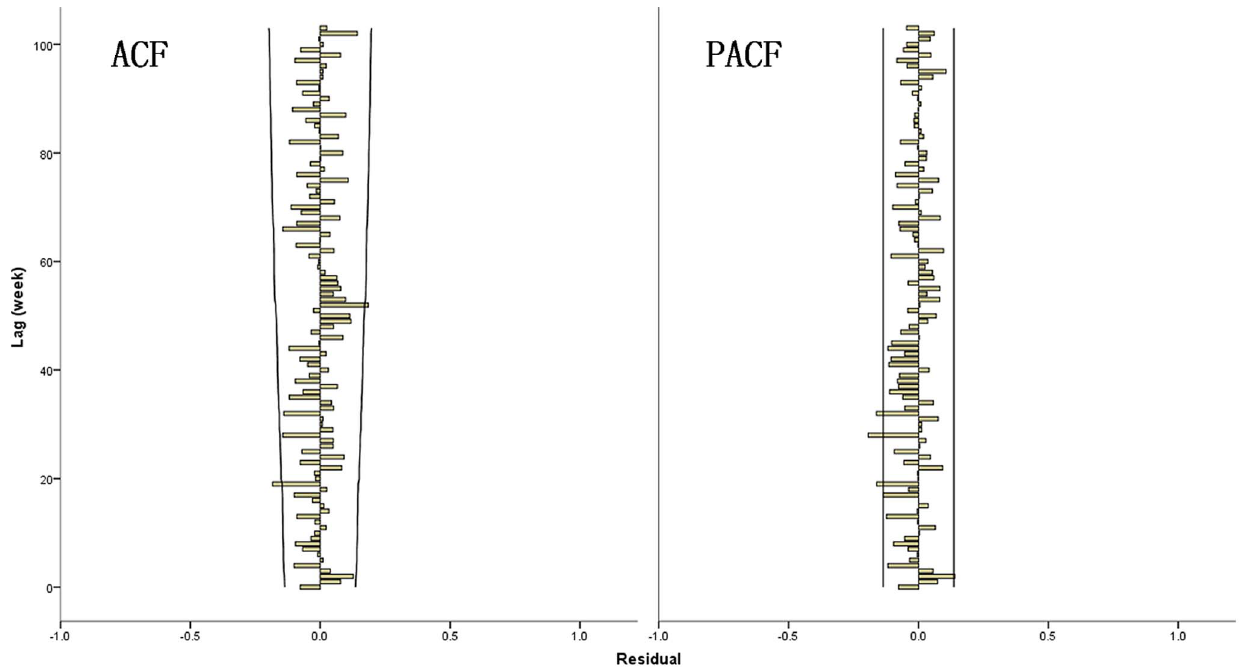
Figure 4. Autocorrelation function (ACF) and Partial ACF (PACF) plot of residuals after applying a SARIMA (1, 1, 1) (1, 0, 0) 52 model. The x-axis gives the number of lags in weeks and, the y-axis, the value of the correlation coefficient comprised between 2 1 and 1. Dotted lines